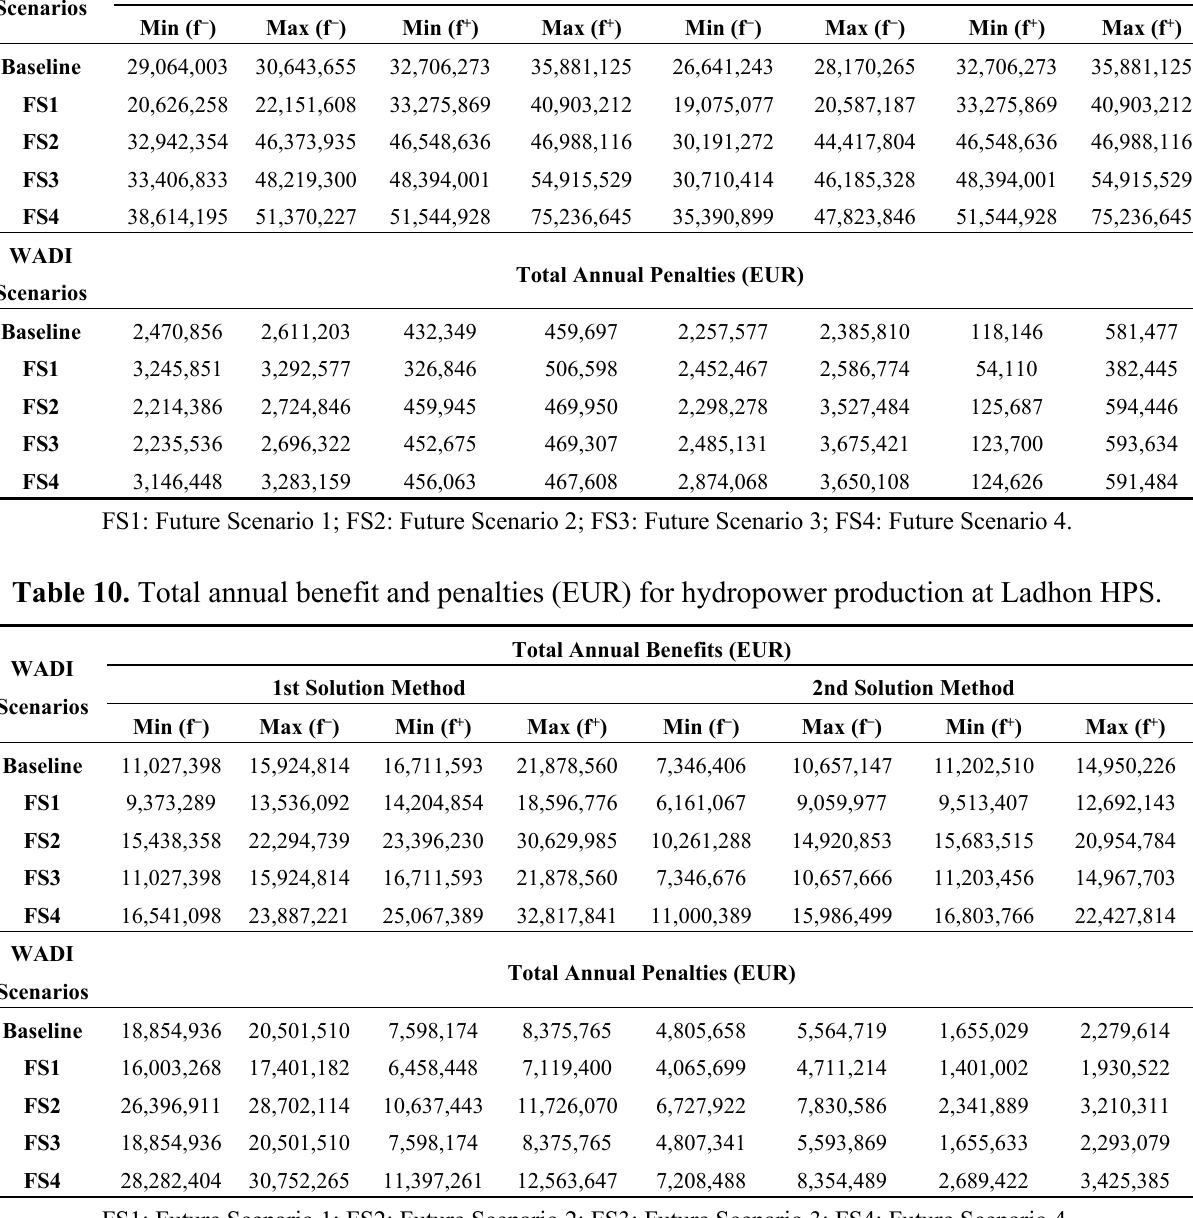
Table 9. Total annual benefit and penalties (EUR) for irrigation at Flokas. WADI